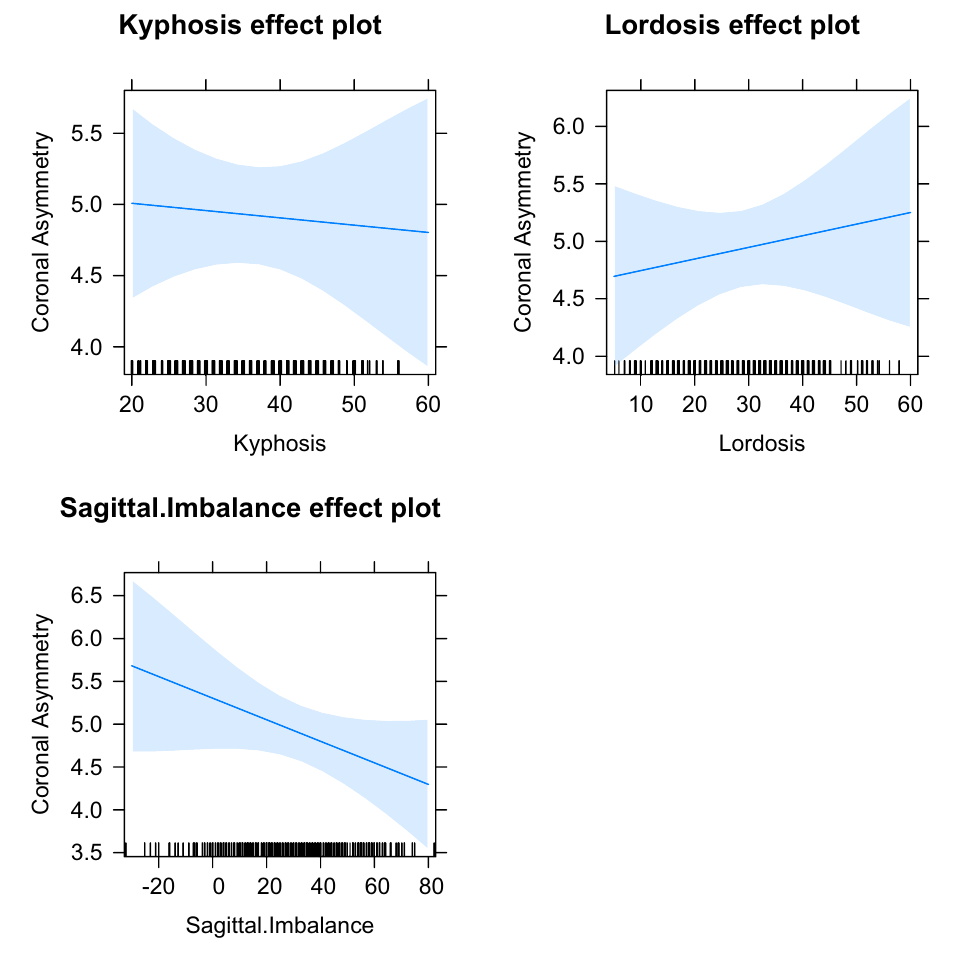
Figure 5. All effects model plot